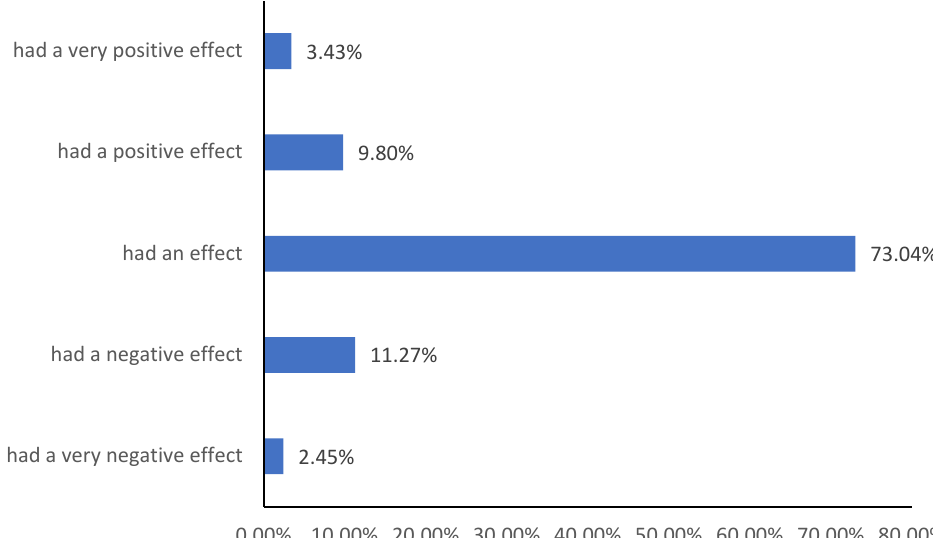
Figure 4. Did the necessity to switch to remote working mode in your opinion affect mutual trust at work? The impact of trust on relationships in the context of the need to move to remote work is examined in the next question. According to 51.96% of people, trust influences relationships; 24.02% assessed it as high and 13.24% assessed it as decisive. Meanwhile, 3.43% of the respondents did not see the impact of trust on relationships, and 7.35% did not have an opinion in this respect. When analyzing the distribution of the obtained answers depending on the respondents’ gender, it was found that women rated this often than men as decisive or high, respectively: decisive, women 14.02%, men 12.37%; high: women 26.17%, men 21 65%. On the other hand, men more often than women men 53.61%, women 50.47%; none, men 4.12%, women 2.80%. The study also found